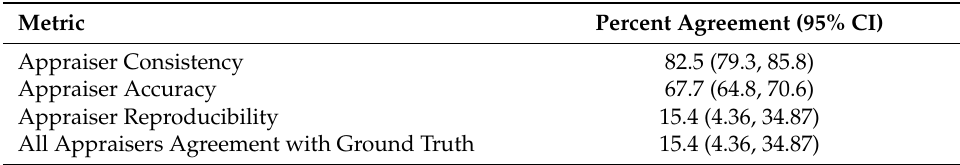
Table 4. Summary of Attribute Agreement Analysis results.